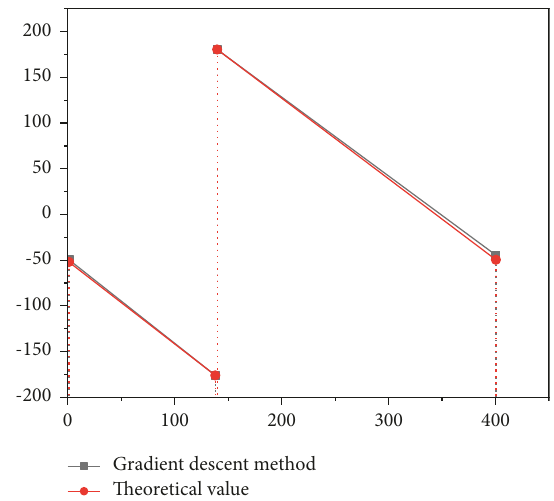
Figure 5: Comparison of course angle calculation results and theoretical values based on gradient descent under high dynamic.